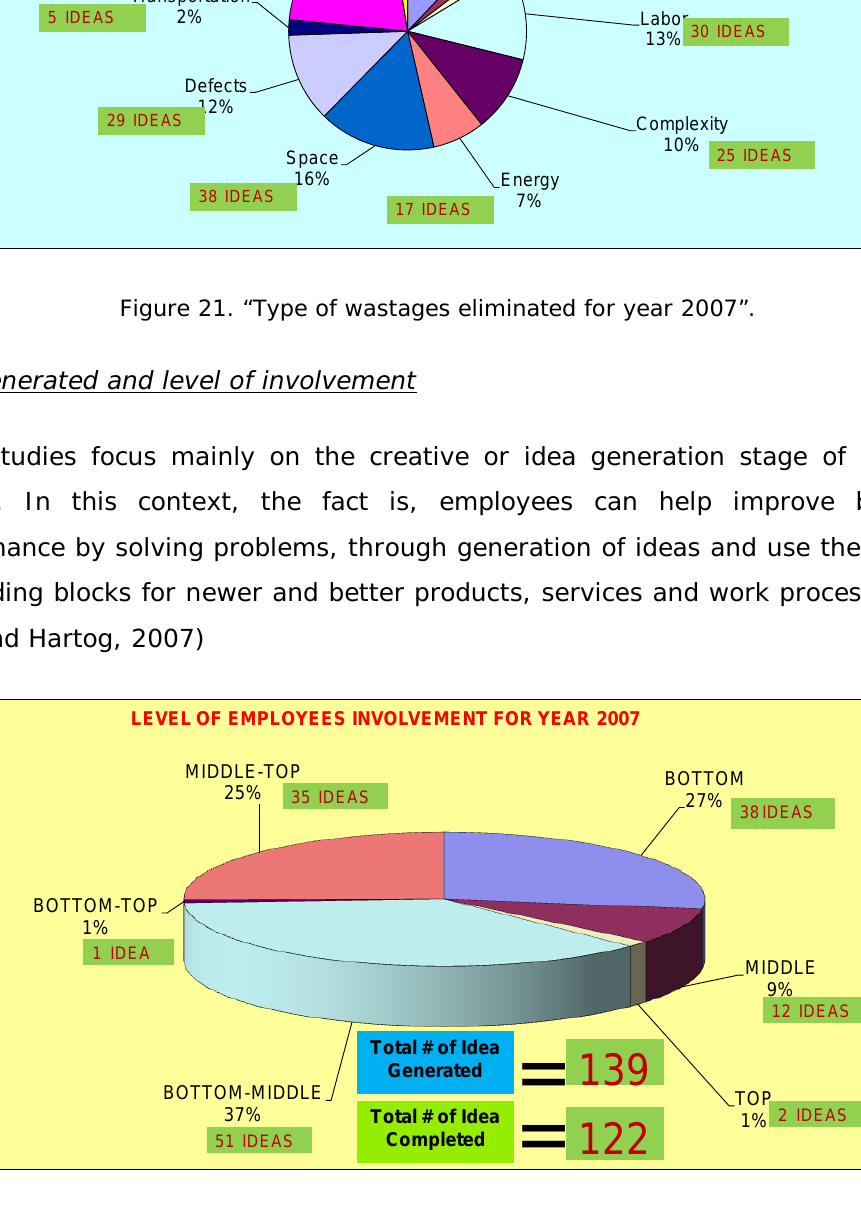
Figure 22. “Level of employees’ involvement for year